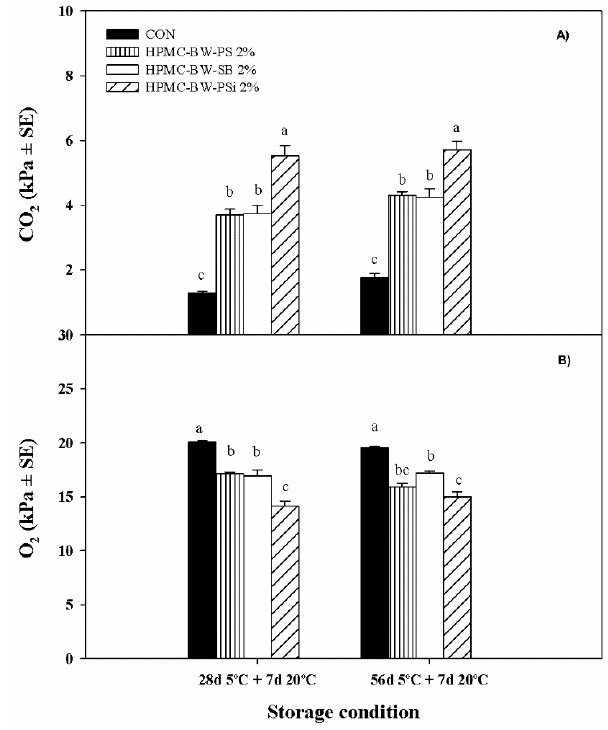
Figure 2. Internal CO 2 ( A ) and O 2 ( B ) concentrations of “Valencia” oranges uncoated (CON) or coated with antifungal hydroxypropyl methylcellulose (HPMC)-beeswax (BW) composite edible coatings and stored at 5 °C followed by 7 d at 20 °C. Coatings contained 2% potassium sorbate (PS), 2% potassium silicate (PSi) or 2% sodium benzoate (SB). For each storage period, columns with different letters are significantly different according to Fisher’s protected LSD test ( P < 0.05) applied after the ANOVA. Table 4. Sensory quality attributes of “Valencia” oranges coated with hydroxypropyl methylcellulose (HPMC)-beeswax (BW) composite edible coatings containing GRAS salts and stored at 5 °C followed by 7 d of shelf life at 20 °C.